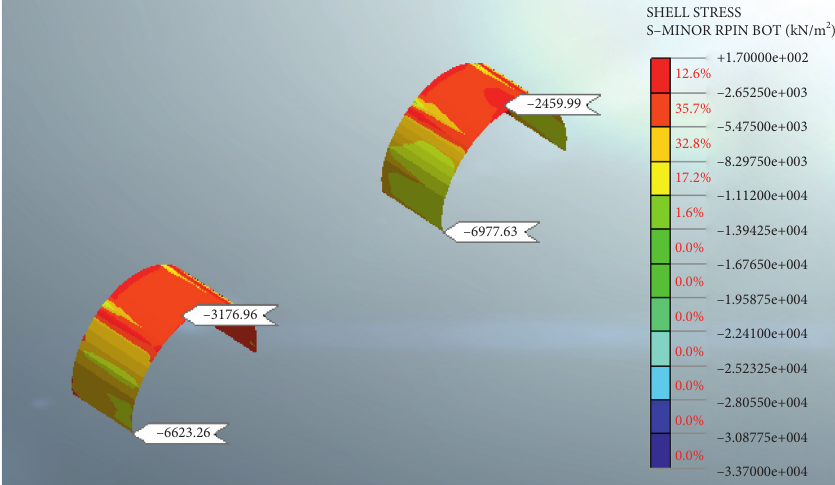
Figure 15: Initial lining stress distribution in double-side guide pit